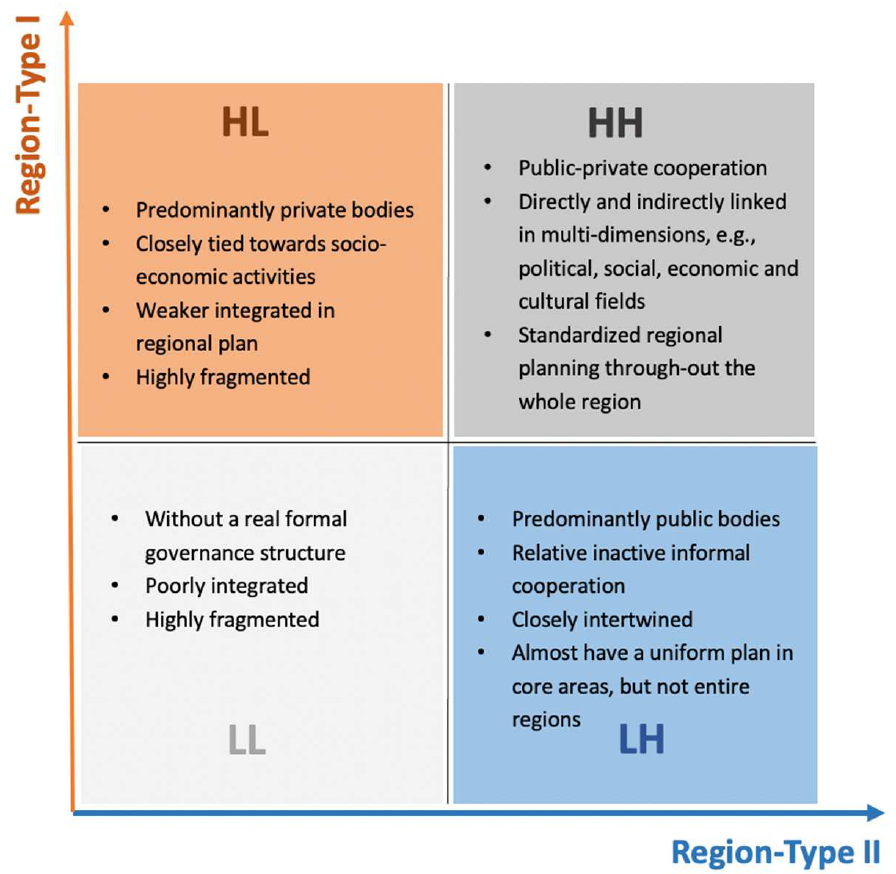
Figure 2. Situations of the governance structure of European Metropolitan Regions (EMRs) in Germany. Source: the authors, based on Diller and Eichhorn [15] (p. 18).